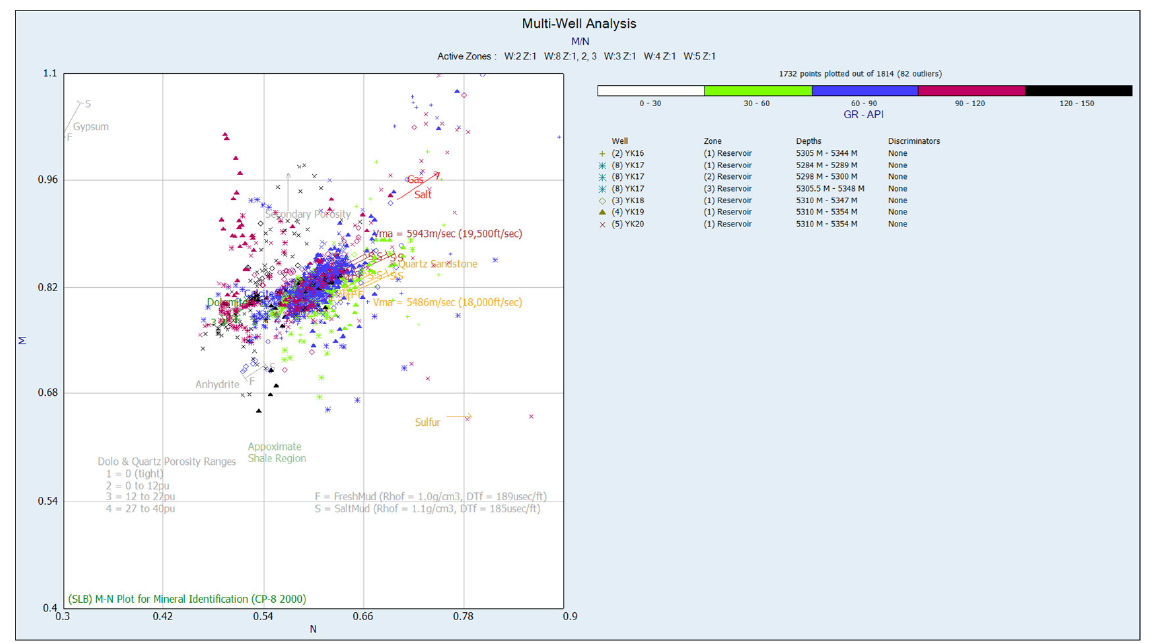
Figure 11. M-N cross plot for multi-well analysis with discriminator gamma ray response. Table 2. Summary of petrophysical estimates (Ave) in proposed zones of the Yageliemu clastic reservoir.